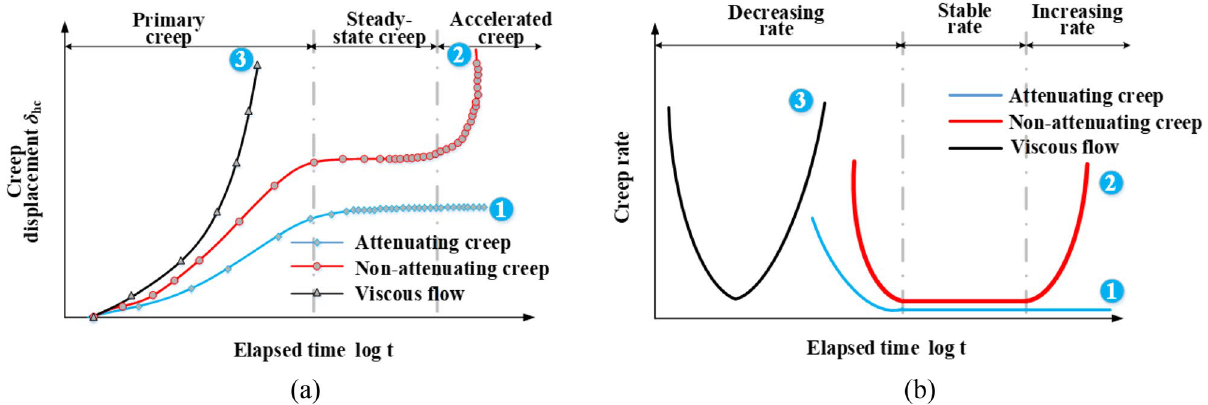
Figure 8. Three typical creep curves: ( a ) creep displacement versus elapsed time, ( b ) creep rate versus elapsed The τ / σ n versus δ h-EOL relationships in Figs. 5, 6 and 7 highlighted the difference in shear behavior between the unreinforced specimen and the reinforced specimen. The τ / σ n versus δ h-EOL curve for the reinforced specimen lay above the τ / σ n versus δ h-EOL curve for the unreinforced specimen. The effect of straw reinforcement caused smaller δ h-EOL prior to failure. In contrast, the lack of straw reinforcement caused larger δ h-EOL prior to failure. Furthermore, the reinforced specimen could withstand higher τ than the unreinforced specimen for the same horizontal displacement.